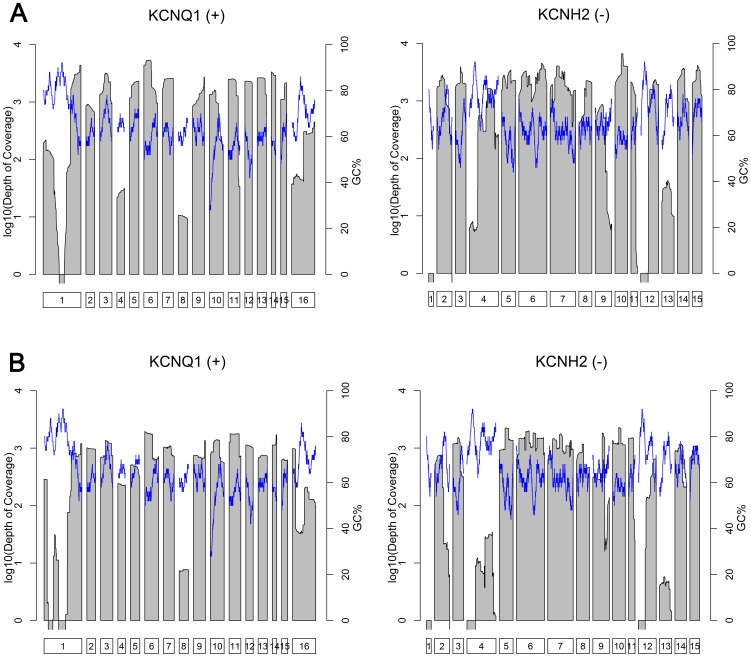
Coverage of KCNQ1 and KCNH2 for the two platforms.Mean depth of coverage for 15 samples is shown for two genes on a log scale. Regions of no coverage therefore have negative values. The blue lines indicate local GC content (calculated with a 50 bp sliding window). Regions consistently missed have high GC content, with similar patterns for both platforms. KCNQ1 exons 1 & 8 and KCNH2 exons 1, 4 & 12 are difficult to sequence. A cartoon of the exon structure is shown beneath each panel. Plus (+) and minus (-) denote gene strand. Plots for all genes are shown in Supporting Information Figure S5. a.) MiSeq b.) Ion Torrent PGM.